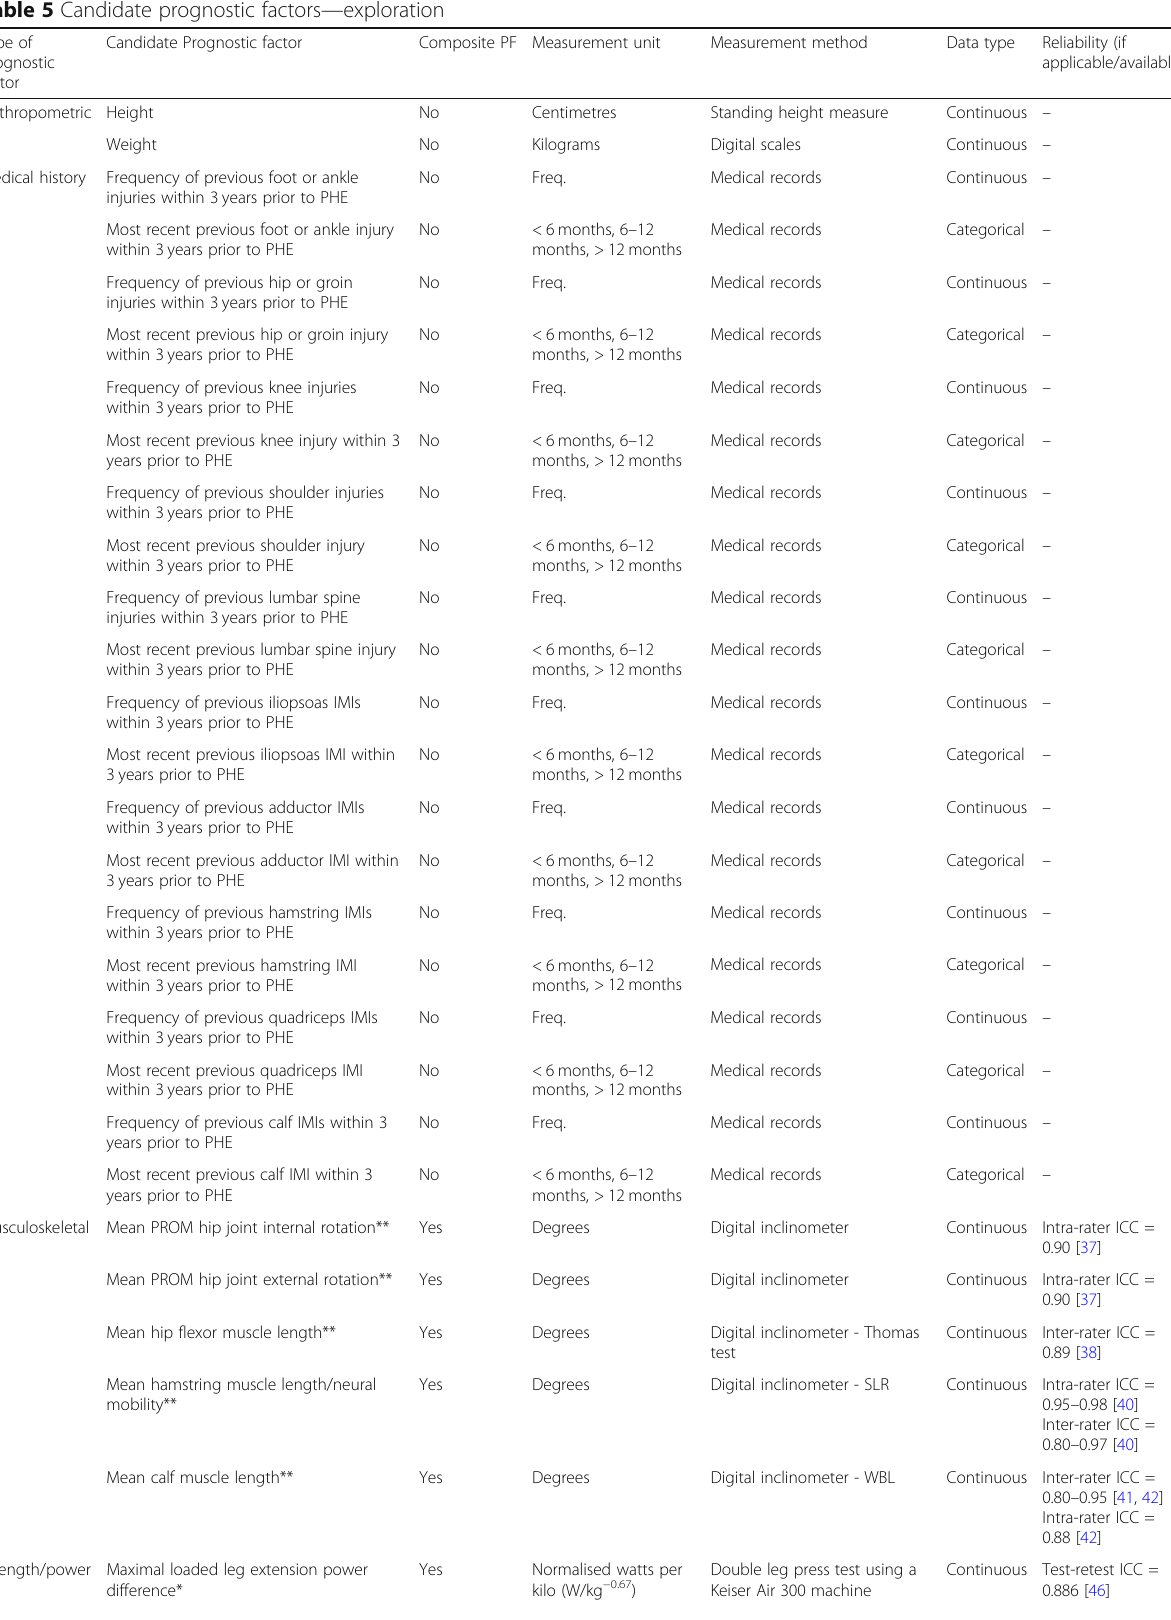
Table 5 Candidate prognostic factors — exploration Type of